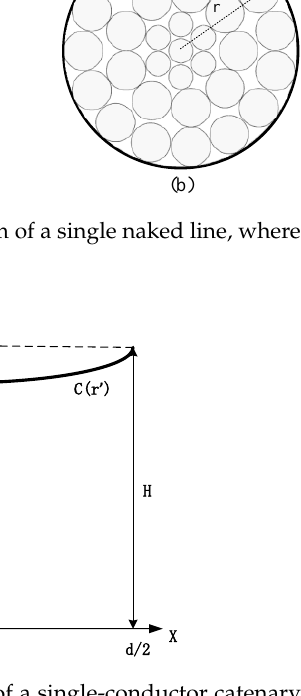
Figure 2. Line parameters of a single-conductor catenary. H is the maximum line height, h is the minimum height ( S = H − h ), and d is the line span length.